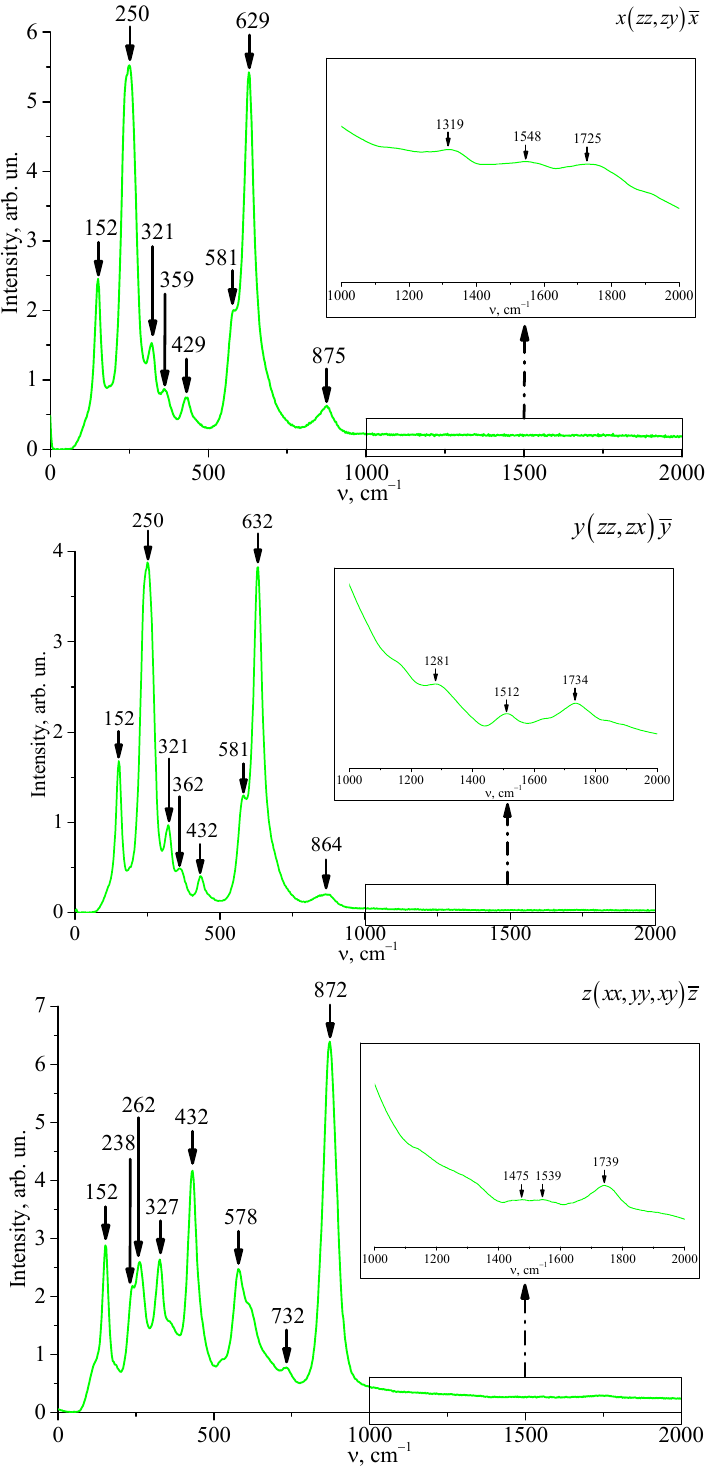
Figure 2. Raman spectra in the band of 50–2000 cm –1 for the backscattering geometry of a LiNbO 3 :Gd 3+ (0.003):Mg 2+ (0.65 wt.%) crystal obtained upon excitation by a laser line with a wave- length of 532 nm.